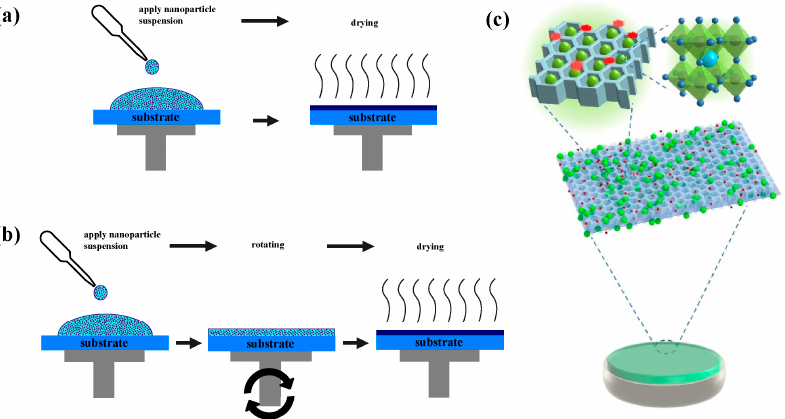
Figure 5. Schematic representation of electrode modification methods. ( a ) Drop-casting technique; ( b ) Spin-coating technique (Reproduced with permission from [61] © TechConnect) ( c ) Molecular imprinting technique [62] © Elsevier.